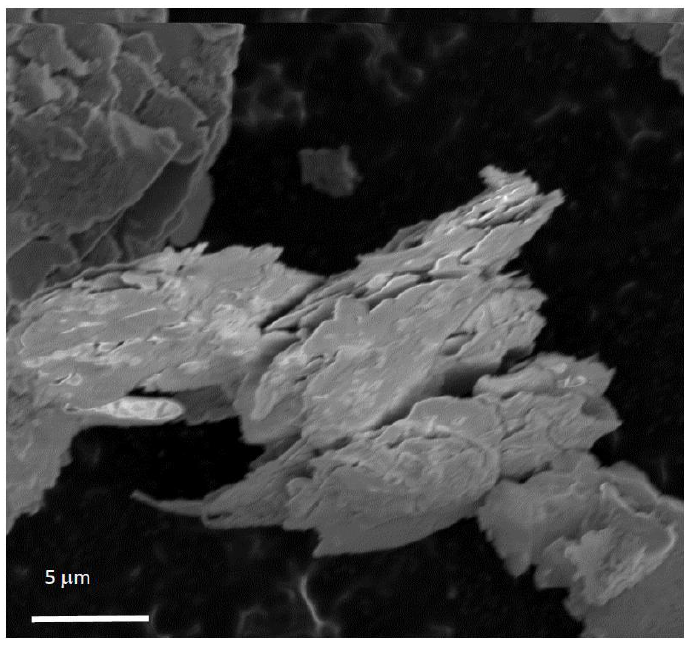
Figure 11. Scanning electron micrograph showing the particle morphology